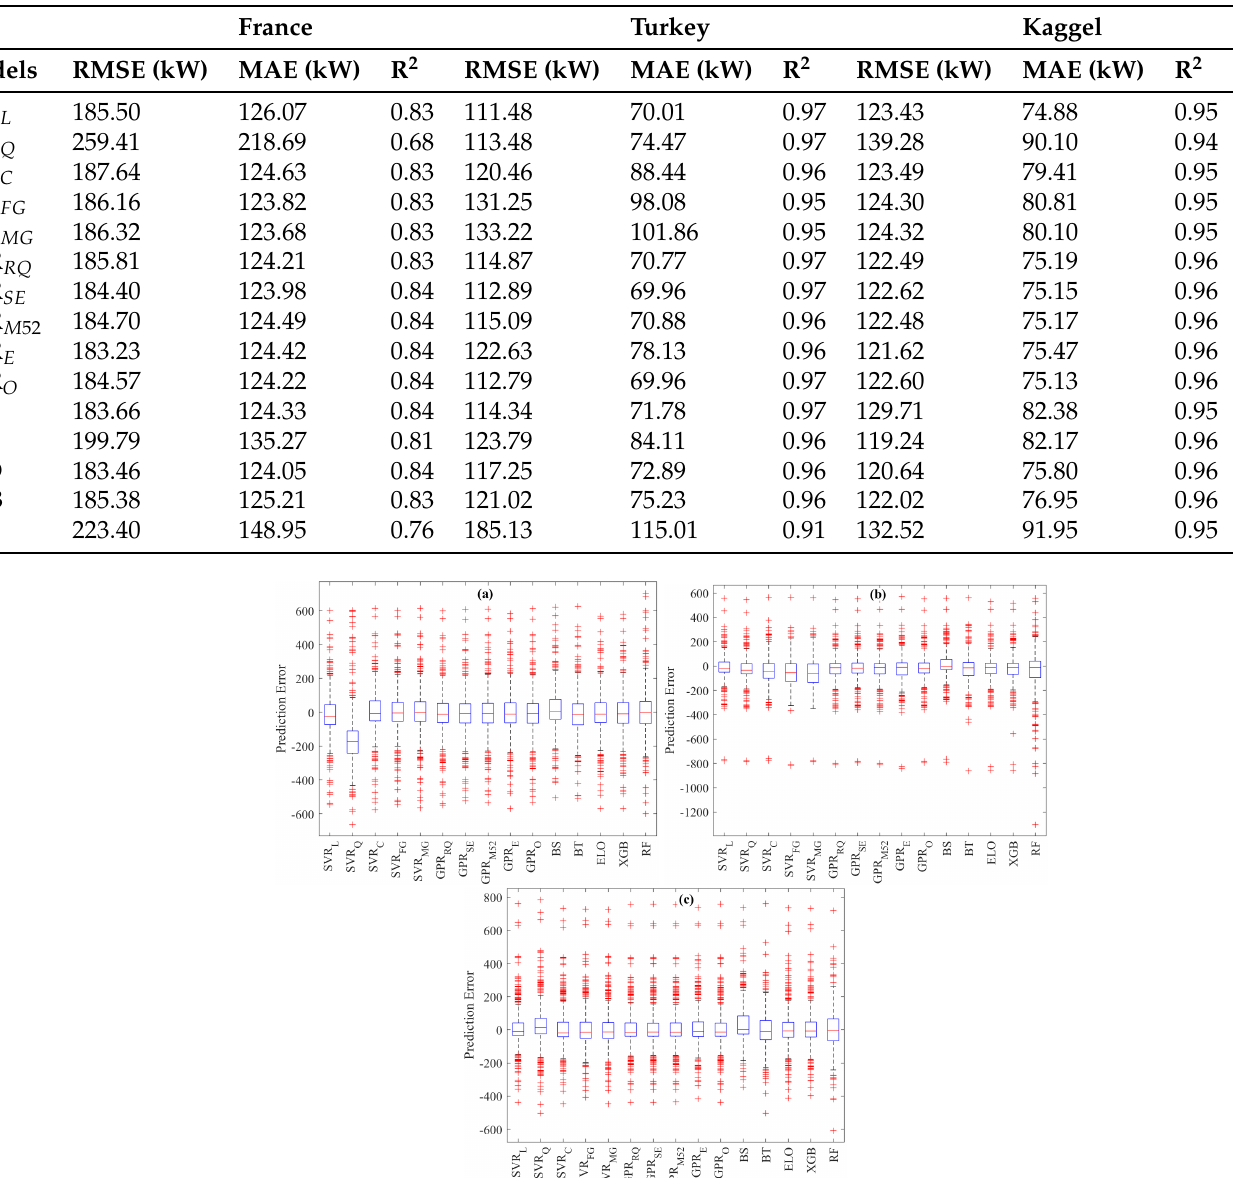
Figure 9. Forecasting errors of the staic models from the testing datasets: ( a ) France, ( b ) Turkey, and ( c )